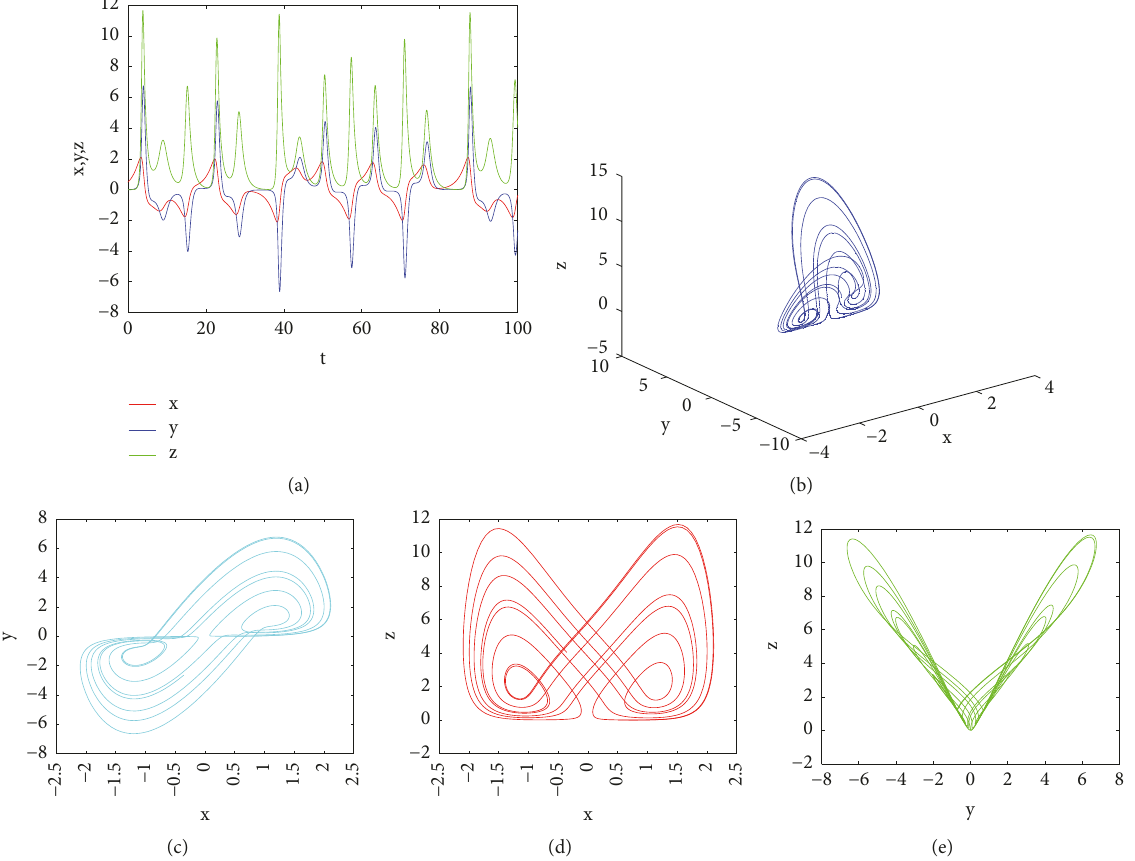
Figure13:ThenewchaoticsystemforExperiment5with 𝑎 = 0.5,𝑏 = −0.1, 𝑐 = 1.5, 𝑚 = 0.12 :(a)timeseriesplot;(b)onthethree-dimensional space; (c) projected on the (𝑥,𝑦) -plane; (d) projected on the (𝑥,𝑧) -plane; (e) projected on the (𝑦,𝑧)